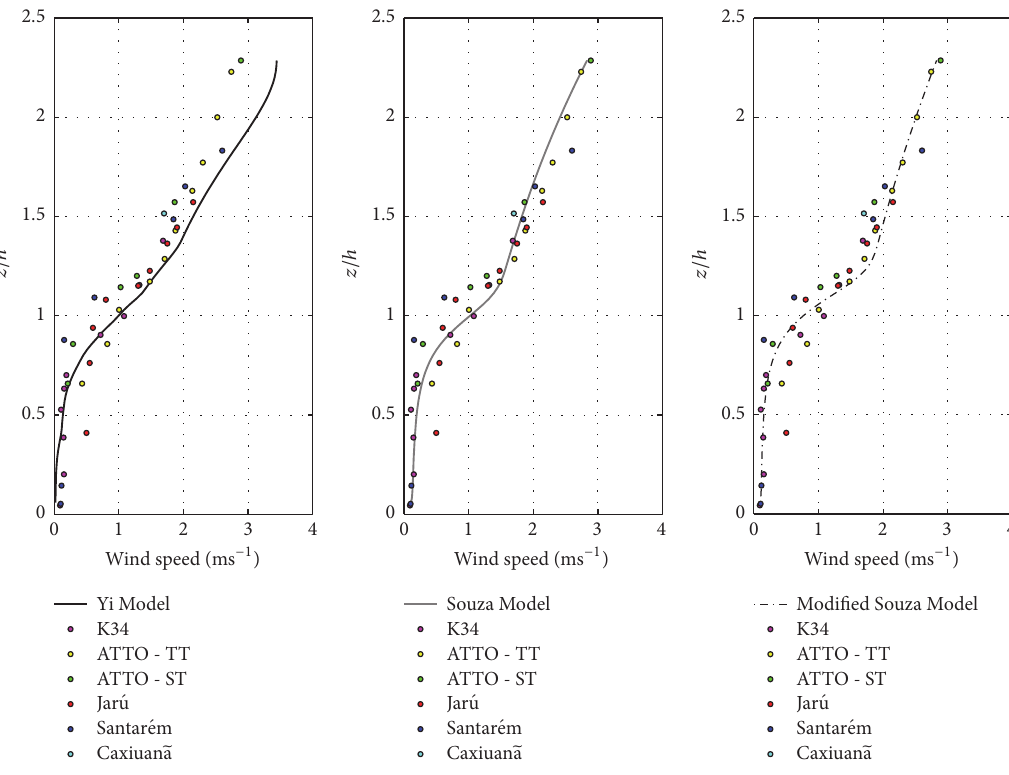
Figure 5: Vertical wind profile observed and modeled in different experimental sites in the